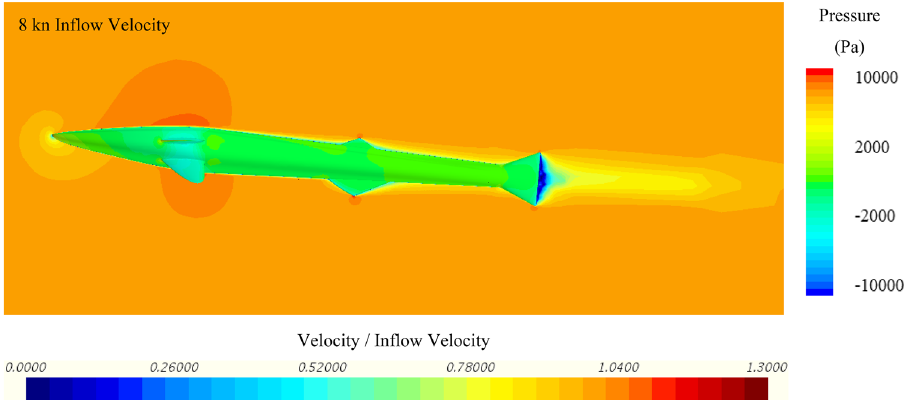
Figure 8. Velocity and pressure contours of the remora fish in free-swimming condition (Pressure contour displayed on the surface of model, and velocity contours displayed on the section plane) (Created using Simcenter STAR-CCM + 2019.2.1 Build 14.04.013).